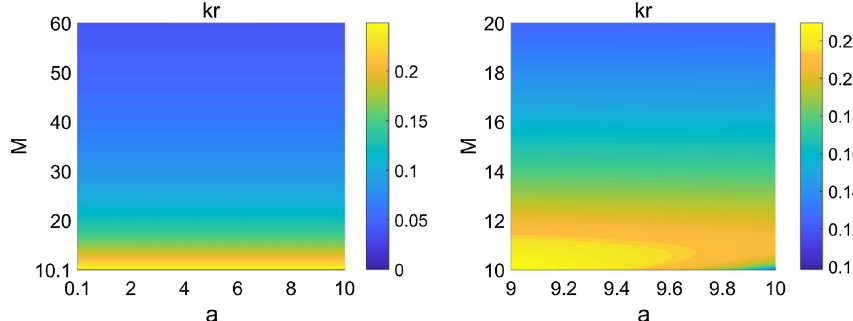
Fig. 1 Left panel: local acceleration κ r vs. mass and angular momentum per mass. Right panel: partial enlarged detail. The system localizes at 1.01 r